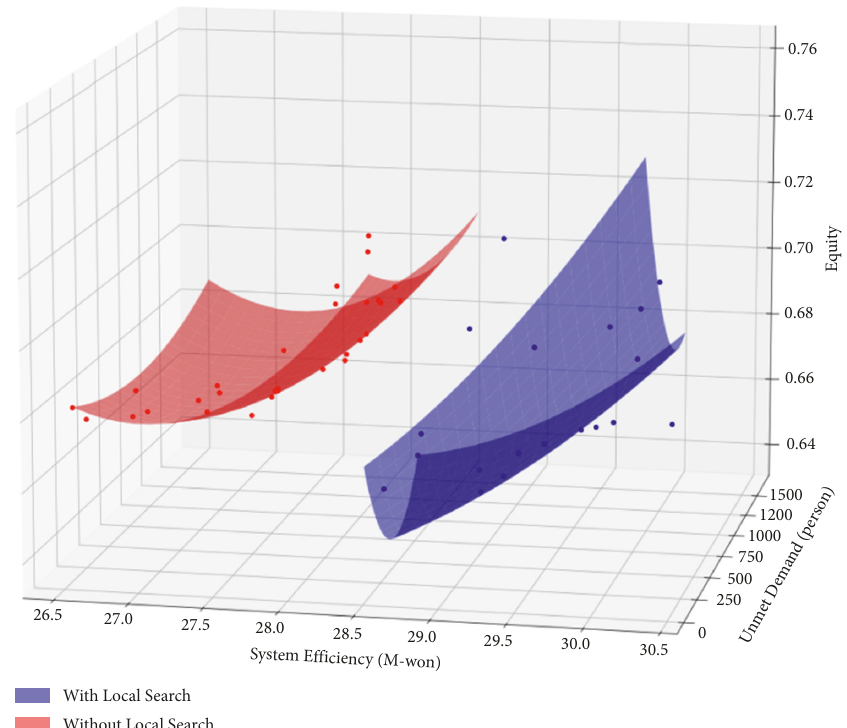
Figure 12: Pareto optimal comparison with and without local search.